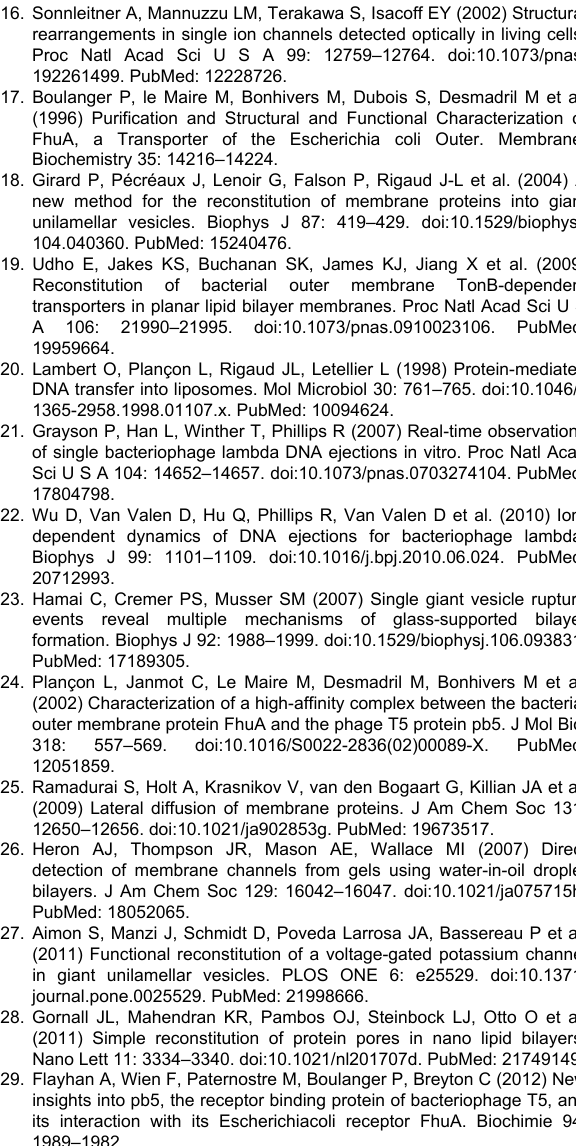
break. Middle: final state of the membrane after rupture. Right: Subtraction of the middle image from the left image. A lookup table is applied to show the negative values in red (membrane that has disappeared), and the positive values in green (membrane that has appeared). Colors are corresponding with B. D\ With glass passivation. Left: sketch showing the two passive glass surfaces: the inside of the capillary and the surface around the supported membrane. Right: putative model of membrane break in the low tension regime: a stable nanohole is nucleated at the edge of the suspended membrane. The nanohole remains below optical resolution but the gigaseal is lost. E\ Membrane patch gigaseal lifetime observed for non passivated glass surface (left, N = 34) and for passivated glass surface (right, N =